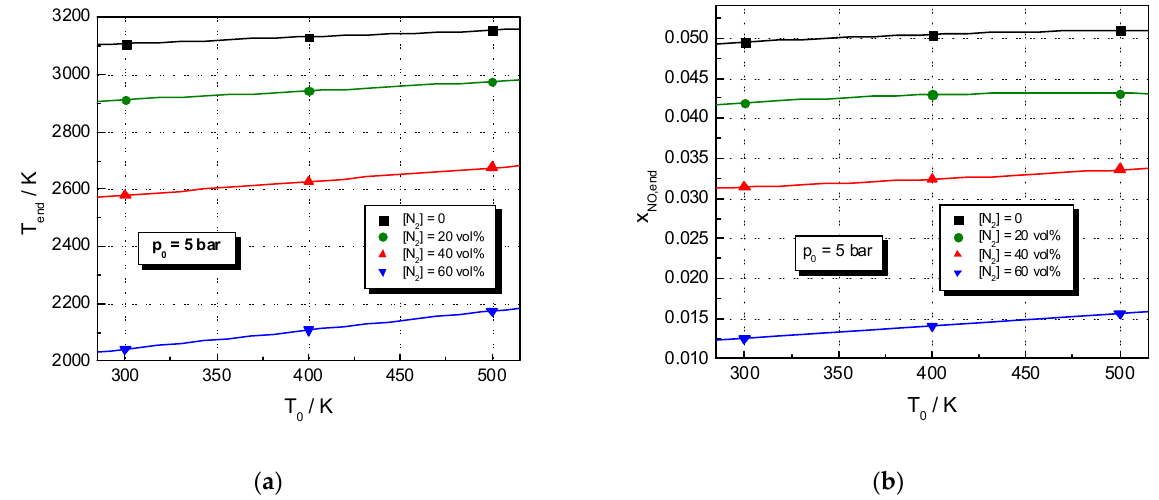
Figure 9. Influence of initial temperature on: ( a ) the end temperature and ( b ) end mass fraction of NO of stoichiometric H 2 –N 2 O mixtures that were diluted with various amounts of N 2 at a constant initial pressure of p 0 = 5 bar. A review of x NO,end variation according to different initial pressures and temperatures of a N 2 -diluted H 2 –N 2 O mixture is shown in Figure 10a,b, using data that were obtained for a mixture that contained 40 vol% of N 2 . At a constant initial temperature, the end mass fraction of NO decreased with the initial pressure. At a constant initial pressure, the end mass fraction of NO increased with the initial temperature.